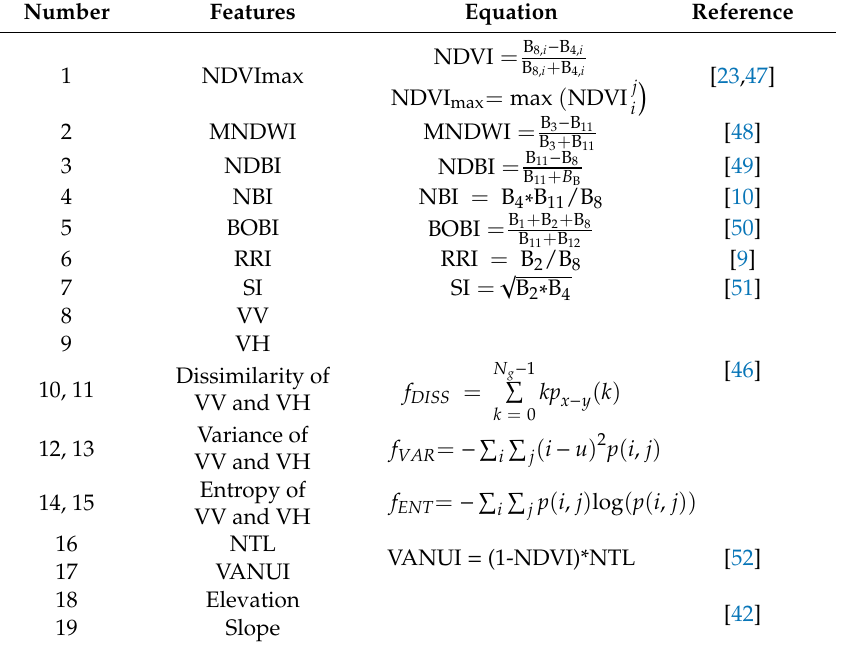
Table 2. Features selected for the extraction of rural settlement. B 1 , B 2 , B 3 , B 4 , B 8 , B 11 , B 12 refers to the numbering system used by the Sentinel 2 Science Mission (e.g., B 4 is the Red Sentinel 2 band, B 8 is the Near Infrared Red Sentinel 2 band). i is the earliest scene and j is the last image acquired in a given Sentinel 2 acquisition time. p ( i , j ) denotes the ( i , j )th entry in a gray-tone spatial-dependence matrix, Ng represents the distinct gray levels of the